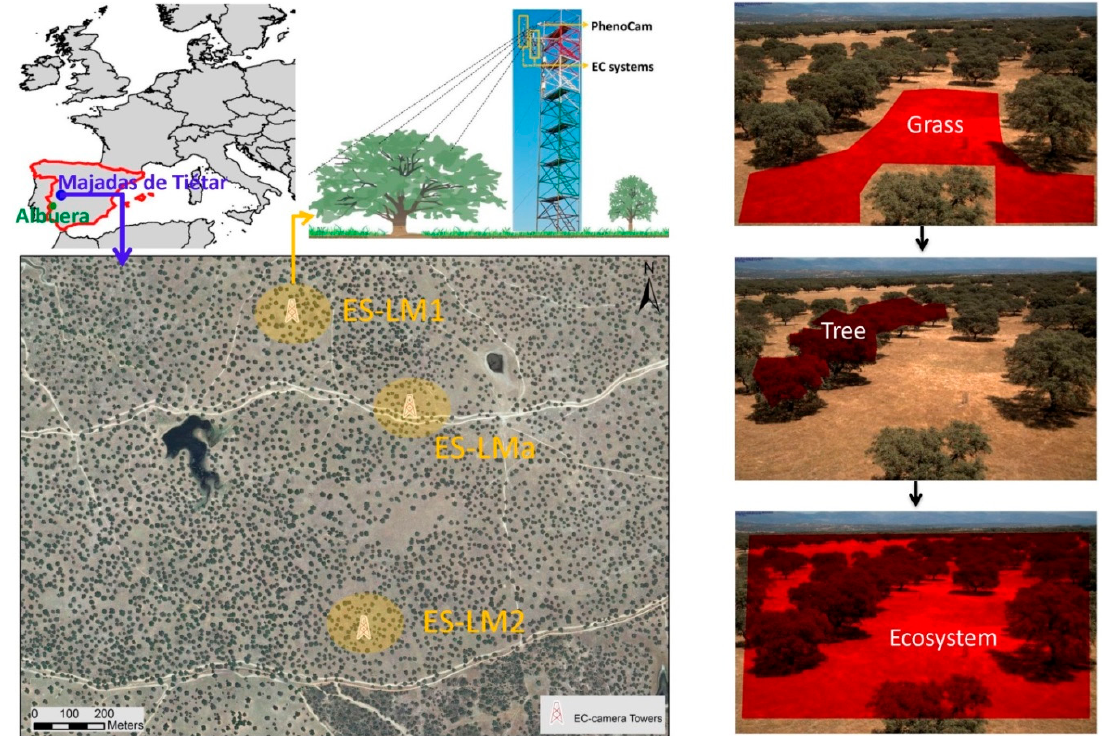
Figure 2. ( left panel ) Experimental setup at Majadas de Ti é tar and La Albuera in Spain and ( right panel ) an example of regions of interest (ROIs) in each experimental site: Grass, Tree and Ecosystem ROIs, respectively. At each site, an eddy covariance (EC) system was installed at a height of 15 m to measure the fluxes of the whole ecosystem. A near-infrared-enabled camera was installed at 15 m beside the EC system to take pictures half-hourly between 10:00 and 14:30. Three EC towers are in the Majadas de Ti é tar (FLUXNET IDs are ES-LM1, ES-LM2, and ES-LMa, respectively) and an EC tower is in the La Albuera (FLUX ID: ES-Abr), respectively (not shown). The map of Majadas de Ti é tar was provided courtesy of the Spanish Program of Aerial Orthophotography. The design of the schematic plot of instruments in the experimental sites refers to [17] and the photo of the EC tower inside the graphic was taken by T.S. El-Madany.